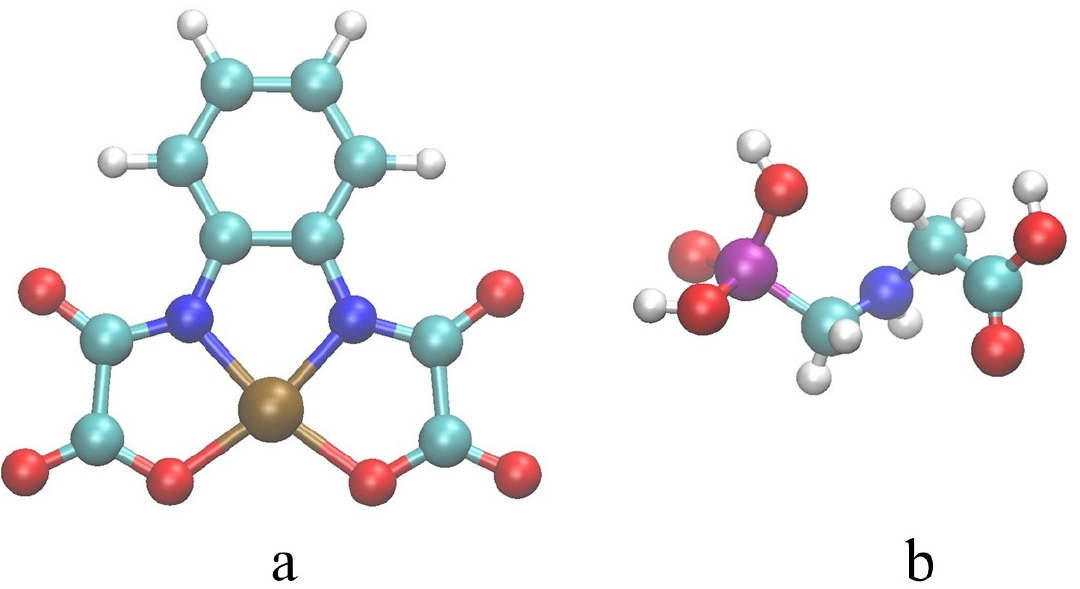
Figure 3. B3LYP/SDD optimized structures of ( a ) [Cu(opba)] 2 − and ( b ) glyphosate. Atom colors: copper (brown); carbon (cyan); nitrogen (blue); oxygen (red); hydrogen (white); phosphorous (magenta). Some bond lengths (in Å): Cu-O (1.97); Cu-N (1.94); C=O (1.27); P-O(H)=1.71; P=O (1.58).